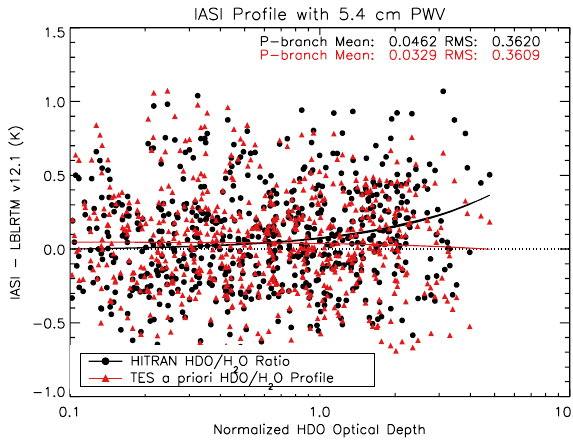
Fig. 18. LBLRTM v12.1 a posteriori (after H 2 O retrieval) bright- ness temperature residuals versus HDO optical depth for a profile with 5.4cm PWV. The black circles show the results when the con- stant HITRAN HDO/H 2 O ratio is used, while the red triangles show the results when the TES a priori profile of the HDO/H 2 O ratio is used. The black and red lines are the corresponding least- squares linear